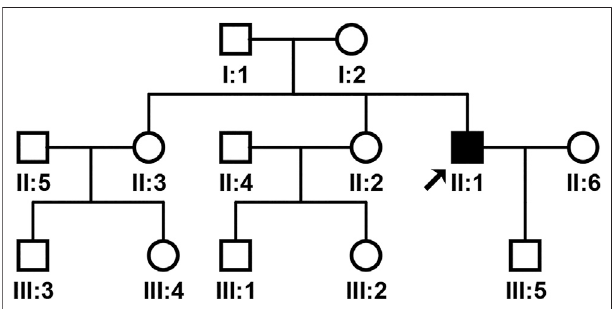
FIGURE 1 | Pedigree of the patient ’ s family. The arrow indicates the